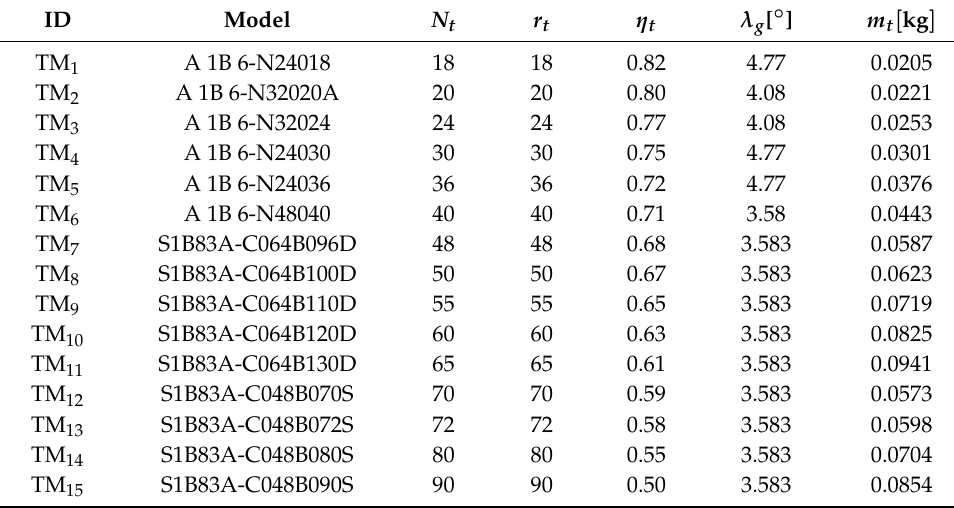
Table 1. Parameters of standard pre-selected worm-gears